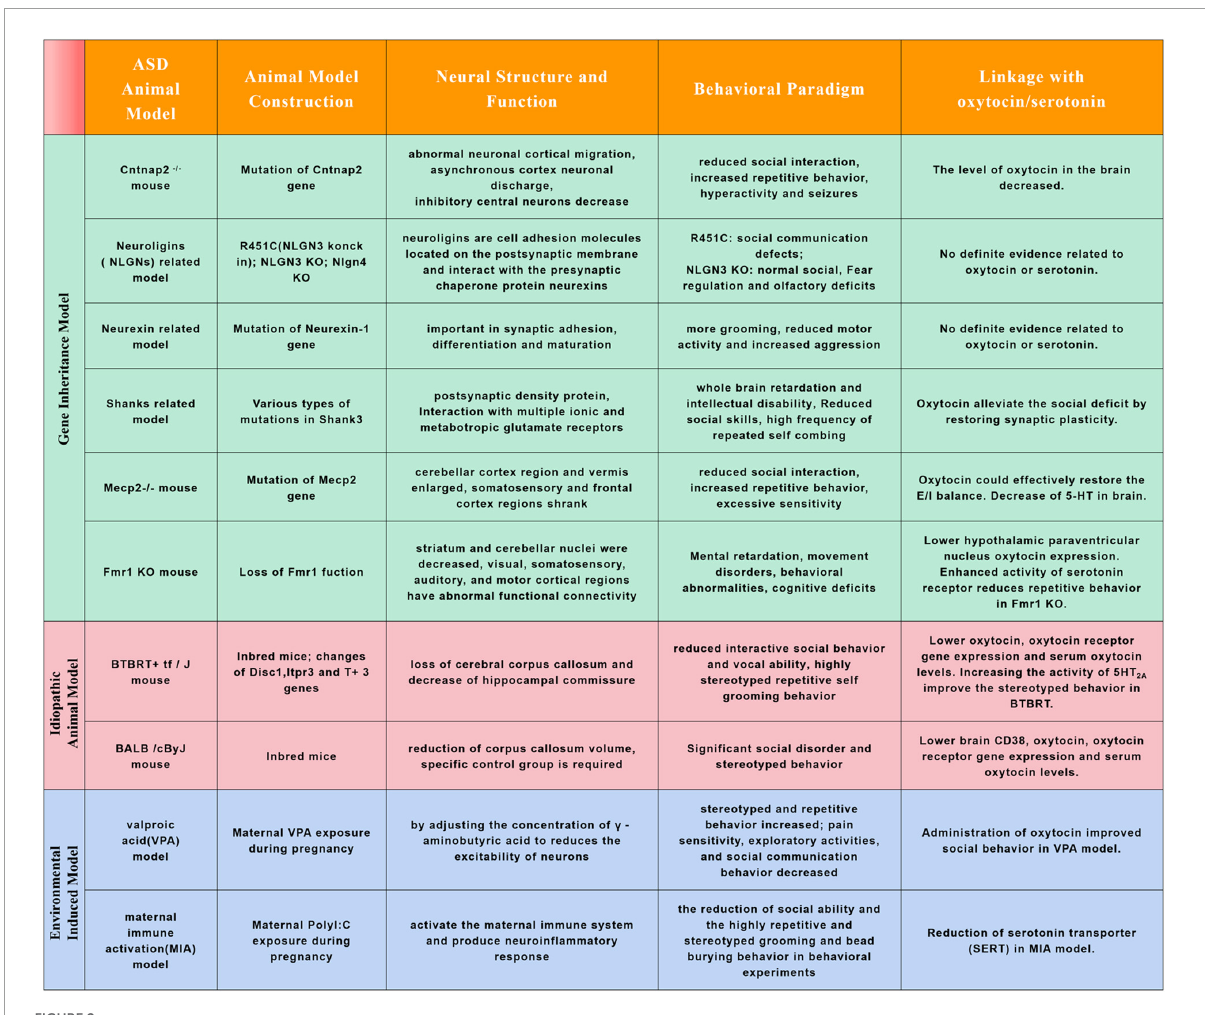
FIGURE2 Commonly used animal models for autism spectrum disorders research and relations with oxytocin or serotonin. Autism spectrum disorder is a highly heterogeneous neurodevelopmental disorder. Its prevalence has been increasing in recent years, but the etiology and pathogenesis of the disease are not clear. It is an inevitable trend to explore its etiology and pathogenesis from animal models. The chart above summarizes the common ASD animal models and their characteristics, and linkage with